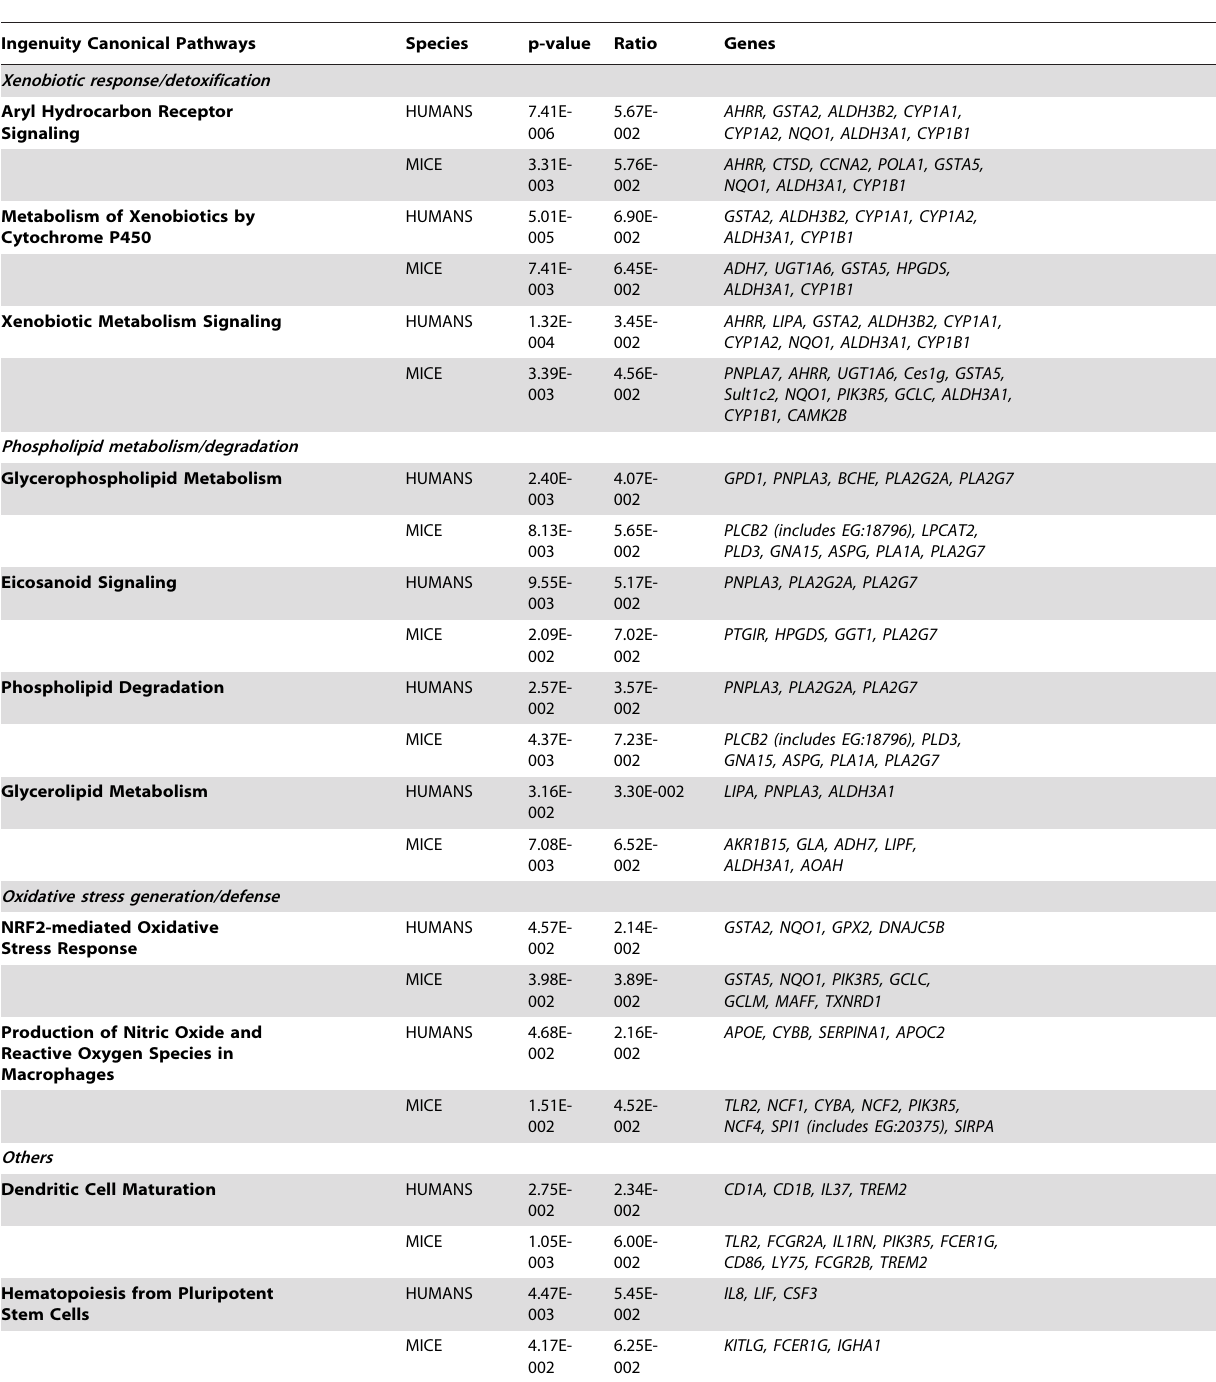
Table 3. Common canonical pathways altered by cigarette smoke exposure in the human and mouse